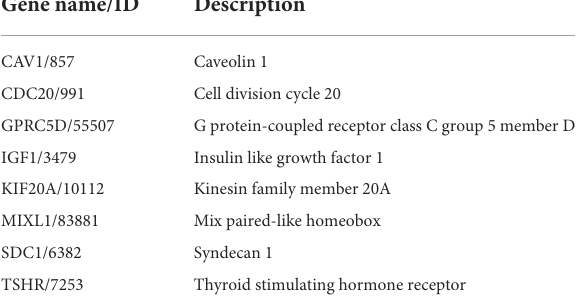
TABLE 5 Eight hub genes validated by GSE157103